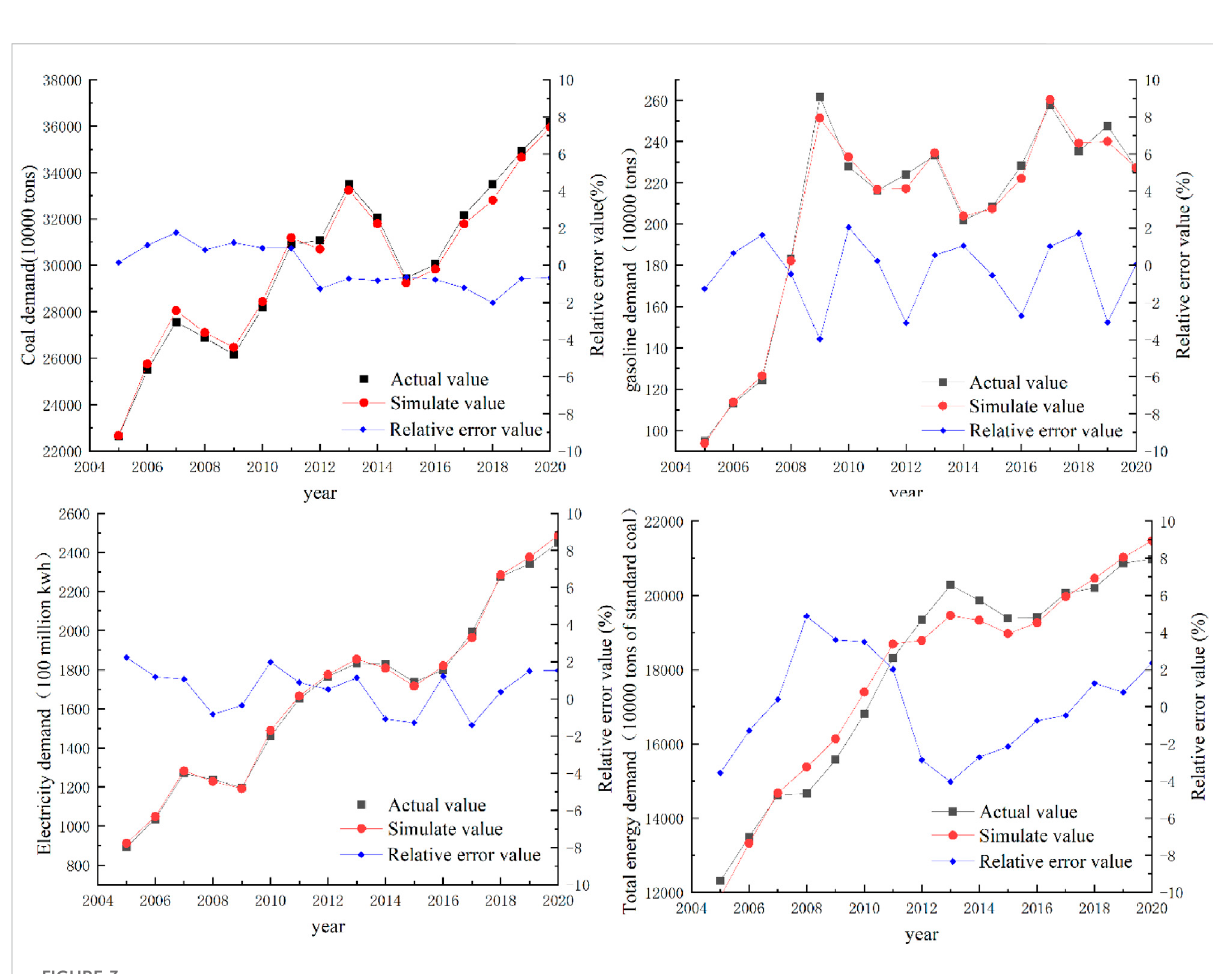
FIGURE 3 Validity test chart of relevant energy